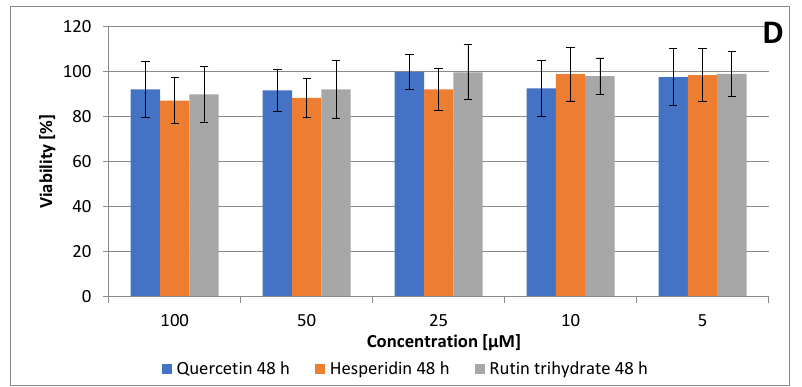
Figure 1. The pharynx squamous carcinoma Detroit 562 ( A and B ) and normal human dermal fibroblasts (NHDF) ( C and D ) cell viability analyzed by MTT (3-[4,5-dimethylthiazol-2-yl]-2,5-diphenylotetrazolium bromide) assay. Cytotoxic, dose- and time-dependent effects of Que, Hes, and Rut at flavonoids concentrations above 25 μM after 24 h ( A ) and 48 h ( B ) of incubation. MTT did not show a major impact of Que, Hes, and Rut below 25 μM on Detroit 562 cells viability rate. In the contrary, no major effect was observed for NHDF cells exposed to flavonoids after 24 hours ( C ) and 48 hours ( D ). The results were presented as the mean and standard deviation of three independent experiments, each using 12 wells. (* p < 0.05, ** p < 0.01, *** p < 0.001; ANOVA Friedman ANOVA test, Wilcoxon test) .